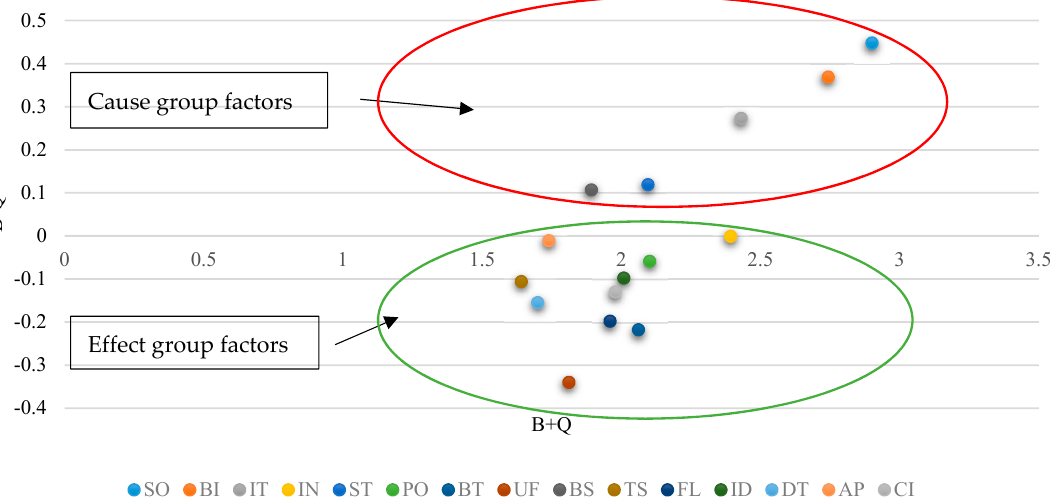
Figure 3. Cause–effect diagram.